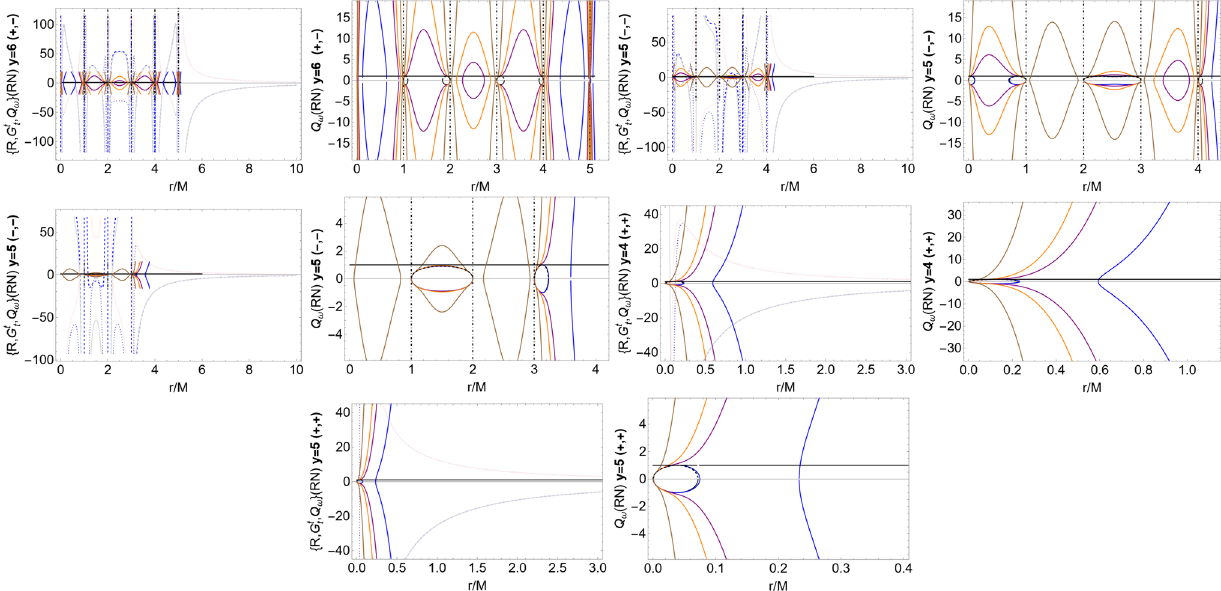
Fig. 21 DeformationoftheReissner–Nordströmreferencemetricwith θ = π/ 2 ( M = 1). Metric bundles Q ω , Ricci curvature scalar R and Einstein tensor component G t t are shown for different metric defor- mation parameters { ( b , f ), y } (metric signature ( − , + , + , + ) ), where { blue , purple , orange , bro w n } curves refer to frequencies { ω =